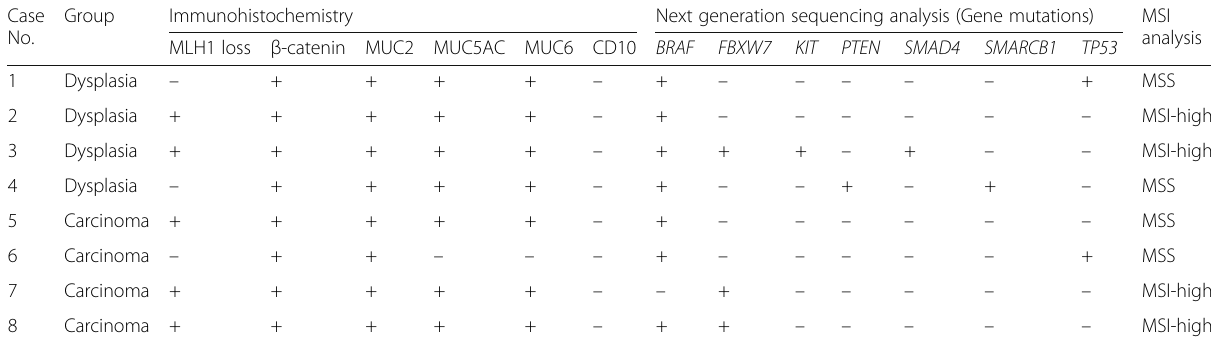
Table 2 Summary of molecular biological features in each case of sessile serrated adenoma/polyp (SSA/P) with dysplasia and invasive adenocarcinoma Case No.